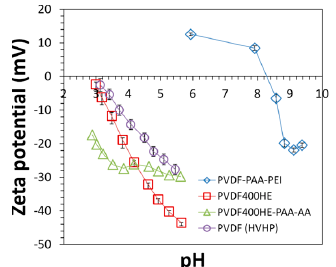
Figure 7. Streaming potentials of PVDF400HE, PVDF400HE-PAA-AA, PVDF400HE-PAA-PEI, and PVDF (HVHP14250) membranes. Electrolyte solution: 0.01 M KCl. PVDF400HE (Nanostone/Sepro) and PVDF400HE-PAA-AA (full-scale) were provided by Nanostone/Sepro. PVDF (HVHP14250) was purchased from EMD Millipore.